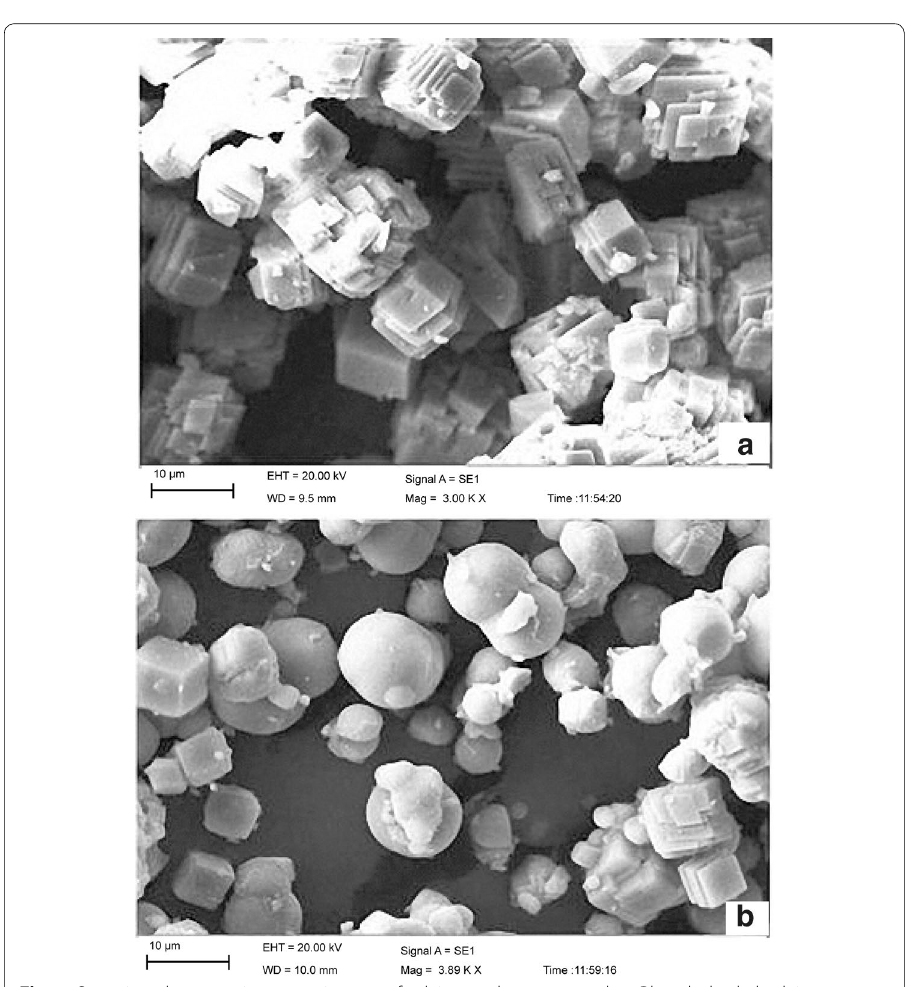
Fig. 4 Scanning electron microscope images of calcium carbonate crystals. a Rhombohedral calcite crystals formed in the presence of CA , b spherical vaterite crystals formed in the absence of CA (Bose and Satyanarayana